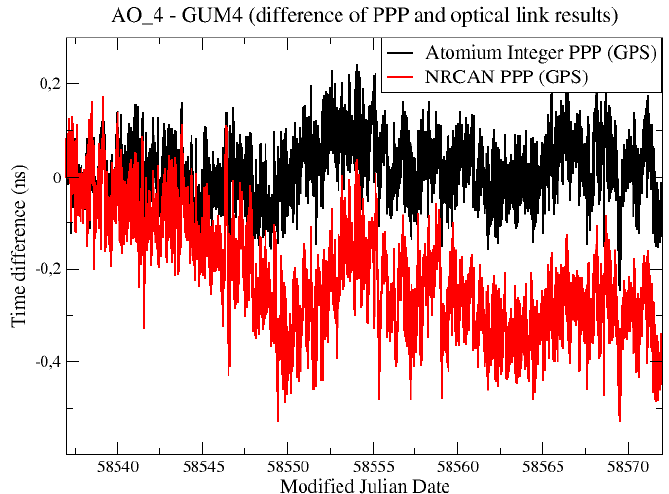
Figure 18. Comparison of integer PPP and NRCAN PPP results.